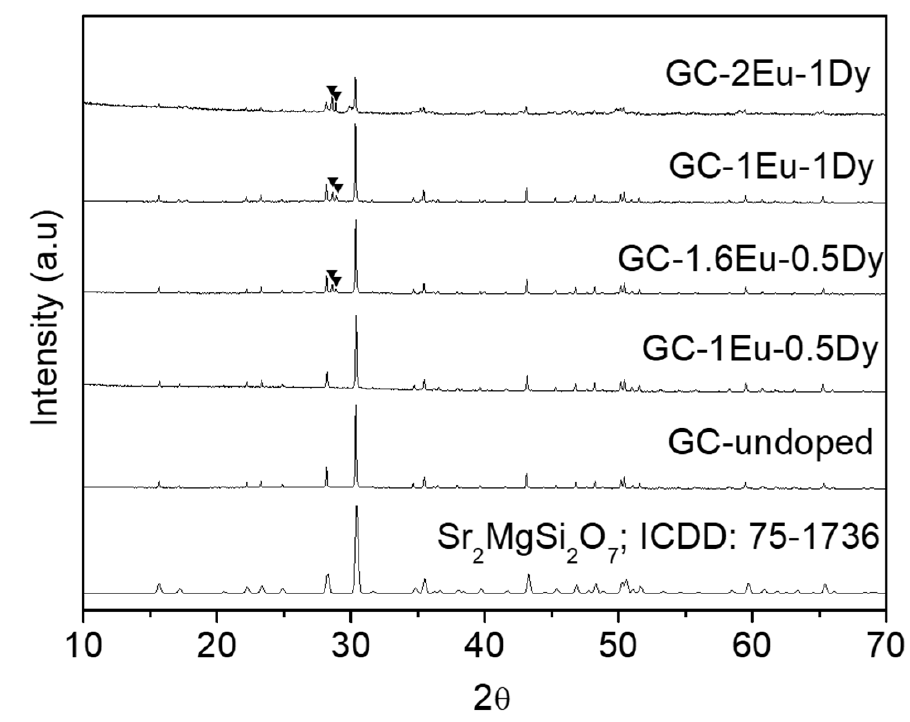
Figure 3. XRD patterns of glass-ceramic samples treated at 1100 ◦ C for 1